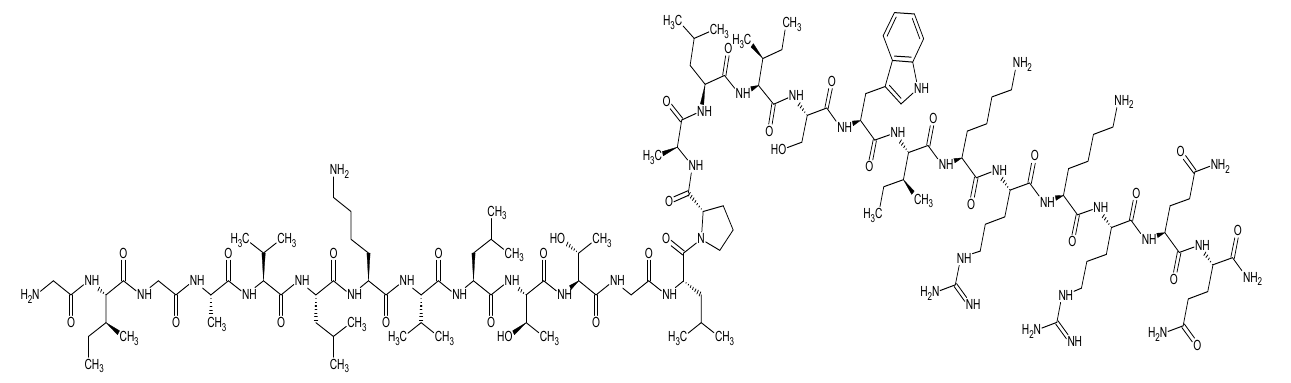
Figure 1. Melittin’s chemical structure which was drawn by ACD/ChemSketch.